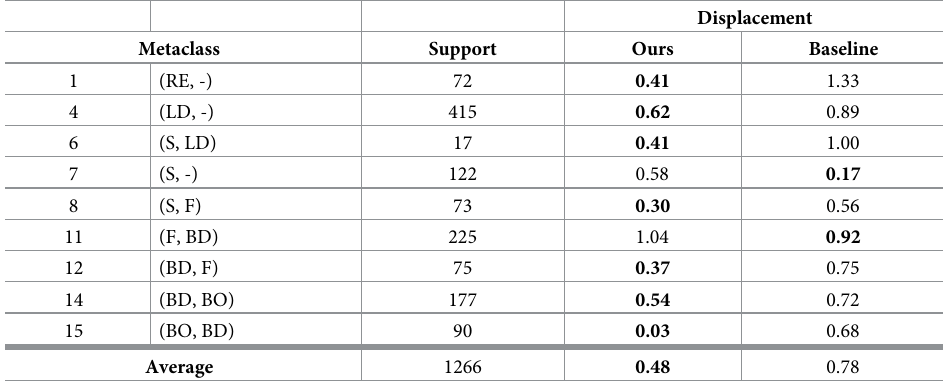
Table 6. Prediction errors in metaclass displacement